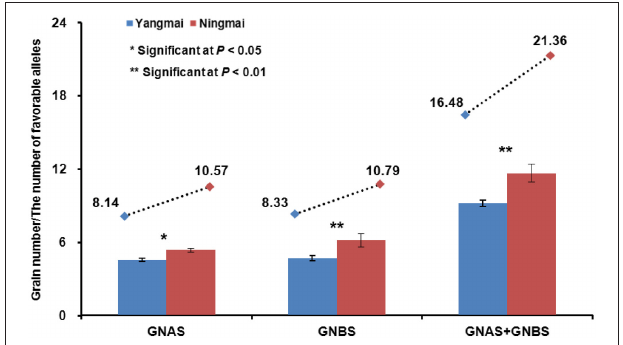
Figure S1 | A schematic representation of the grain set on apical and basal spikelets. Figure S2 | Associations of seven phenotypic traits with 106 SSR markers illustrated as dot plots of compressed MLM at P < 0.01 . The red dotted line indicates the threshold value of significant association.